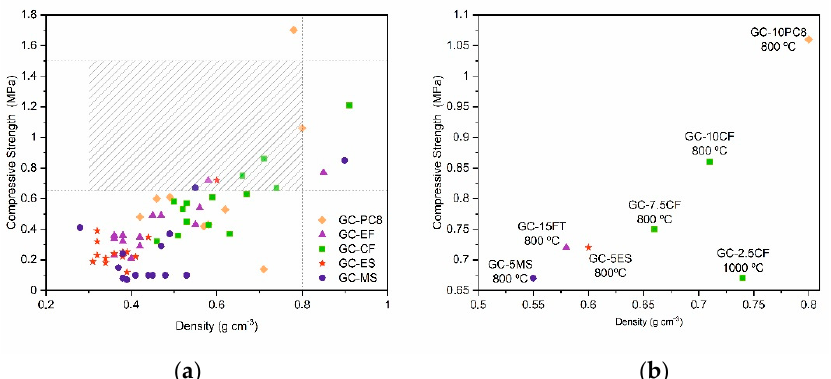
Figure 9. ( a ) Location of all the compositions studied in terms of their density and compressive strength values, and ( b ) magnification of the region dashed in (a), which corresponds to the typical range of values showed by commercial